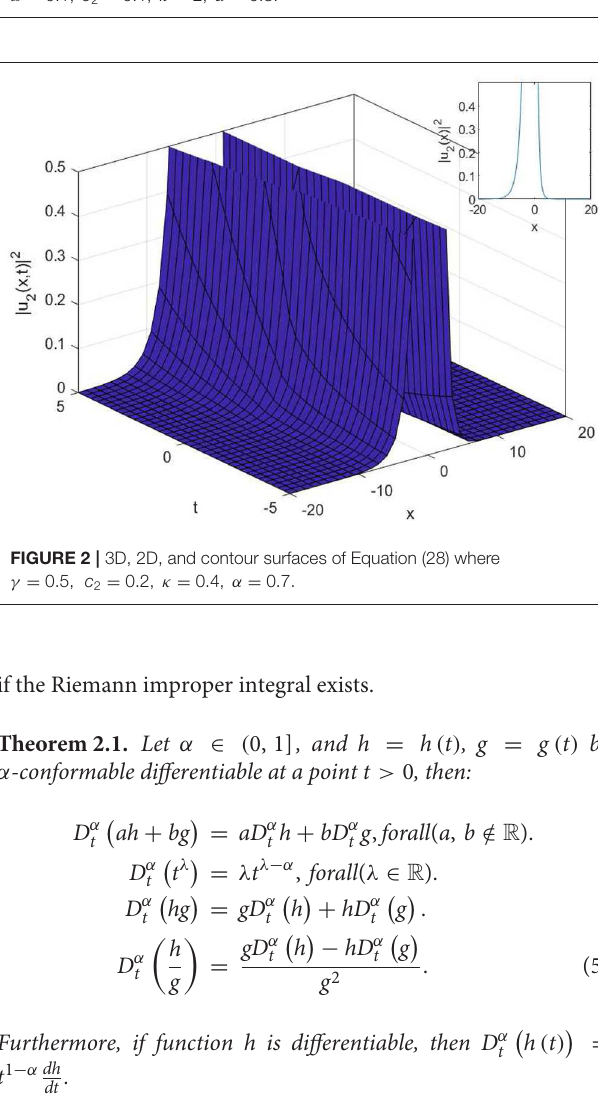
FIGURE 1 | 3D, 2D, and contour surfaces of Equation (26) where ω 0.1, c 2 0.1, κ 2, α 0.8. = = = =